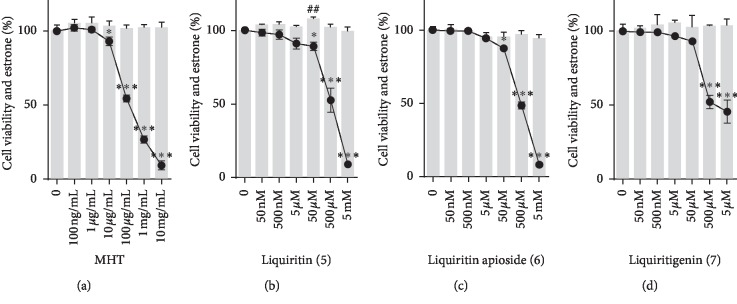
Inhibitory effects of three active compounds of MHT hydrothermal extract, liquiritin (5), liquiritin apioside (6), and liquiritigenin (7), on aromatase activity as determined using a cell system. Data represent the means ± SEMs of three experiments. (a)∗p < 0.05, ∗∗∗p < 0.05 vs. the nontreated group. (b)∗p < 0.05, ∗∗∗p < 0.05 vs. the nontreated group, ##p < 0.05 vs. the nontreated group. (c)∗p < 0.05, ∗∗∗p < 0.05 vs. the nontreated group. (d)∗∗∗p < 0.05 vs. the nontreated group.